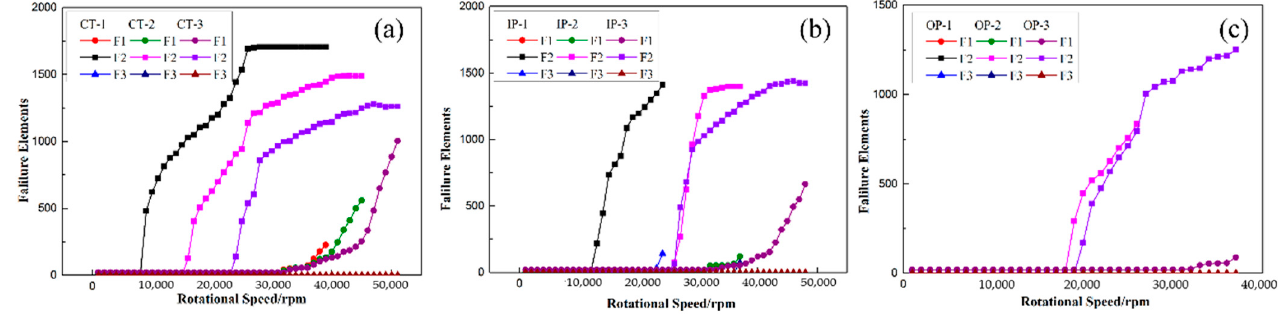
Figure 10. Element failure counts in FEA: ( a ) CTW cases; ( b ) IPWVT cases; and ( c ) OPWVT cases.